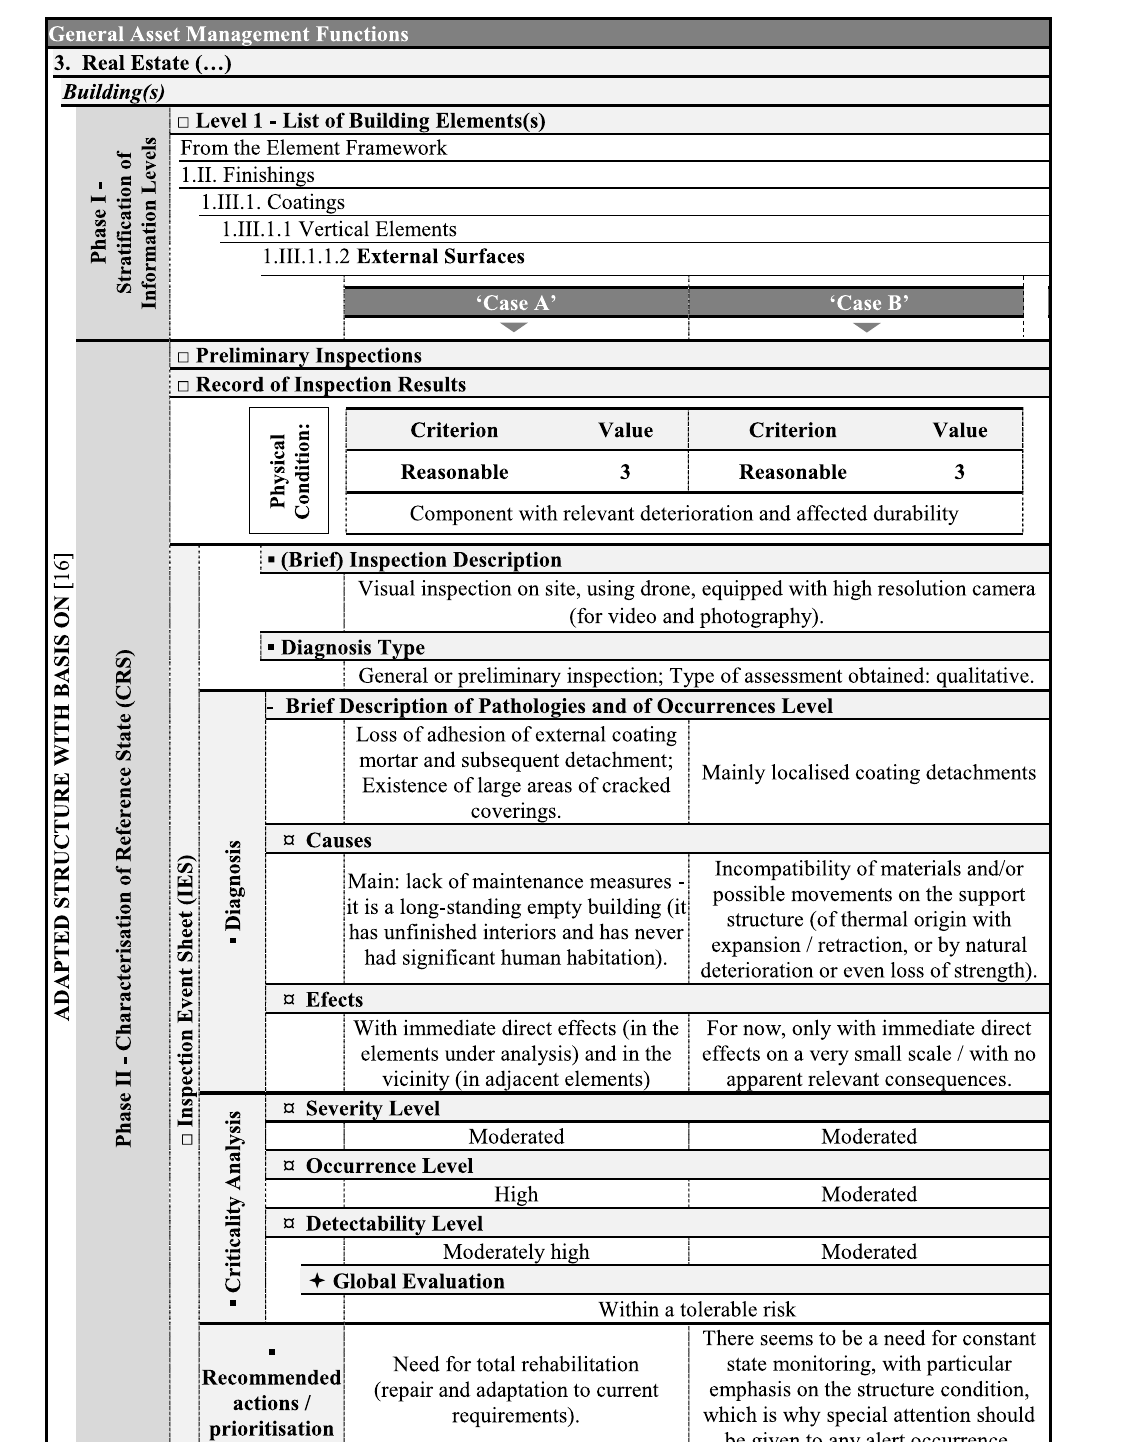
Table 5: Exploratory case studies with drones – summary of results framed in SIAPME